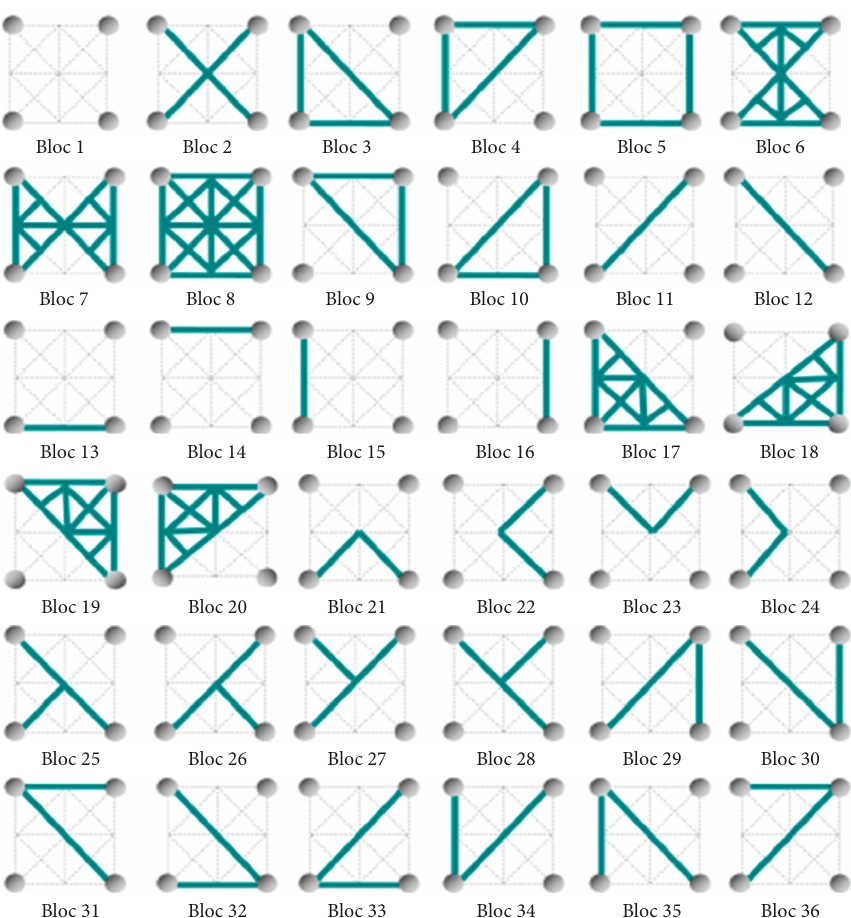
Figure 1: Library of compliant passive, active, or sensitive piezoelectric building blocks for planar compliant mechanisms synthesis using FlexIn.